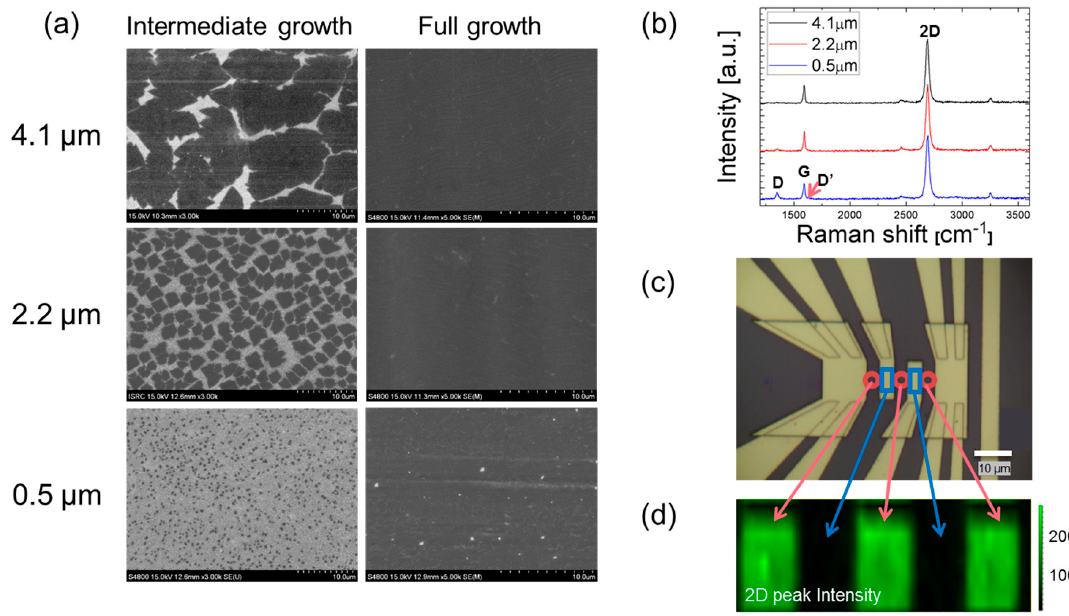
Figure 2. ( a ) SEM images of graphene growth on Cu foil for three different grain sizes. ( b ) Raman spectra of graphene samples laid on the FET substrate. ( c ) Optical image of the 4-point electrodes with graphene sample integrated. ( d ) 2D peak Raman mapping of graphene to distinguish the exposed graphene regions (green) from the electrode-covered regions (black).